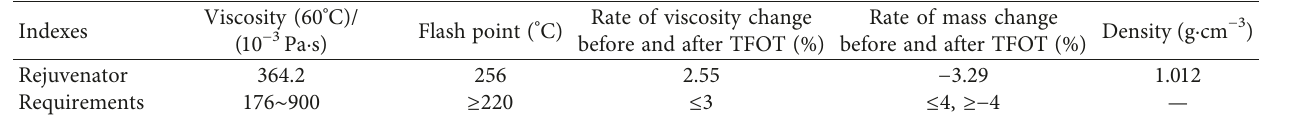
Table 3: The properties of